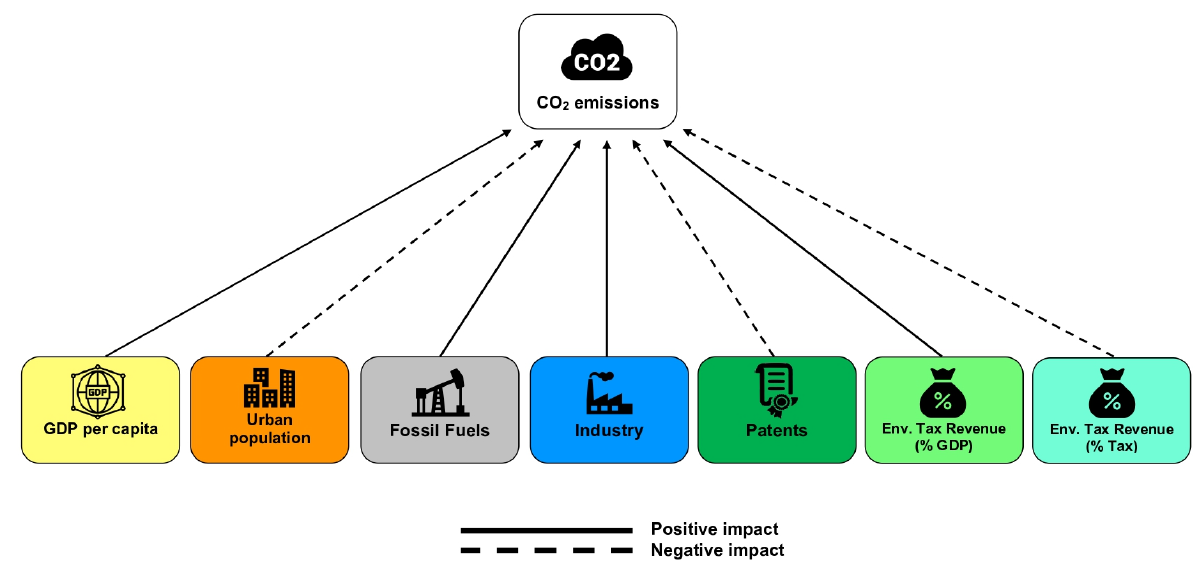
Figure 1. The impact of independent variables on the dependent. This figure was based on the results in Table 9 above. The authors conceived this figure.